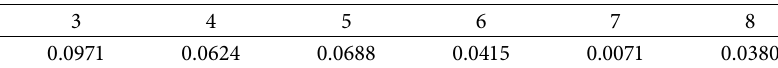
Table 5: Test error result of circular